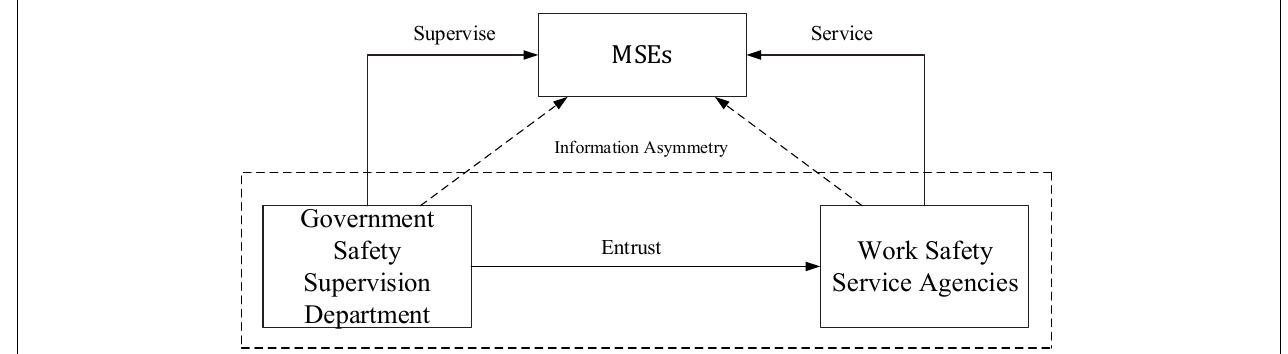
FIGURE 1 | Operating system structure of the work safety behaviors of micro and small enterprises (MSEs).